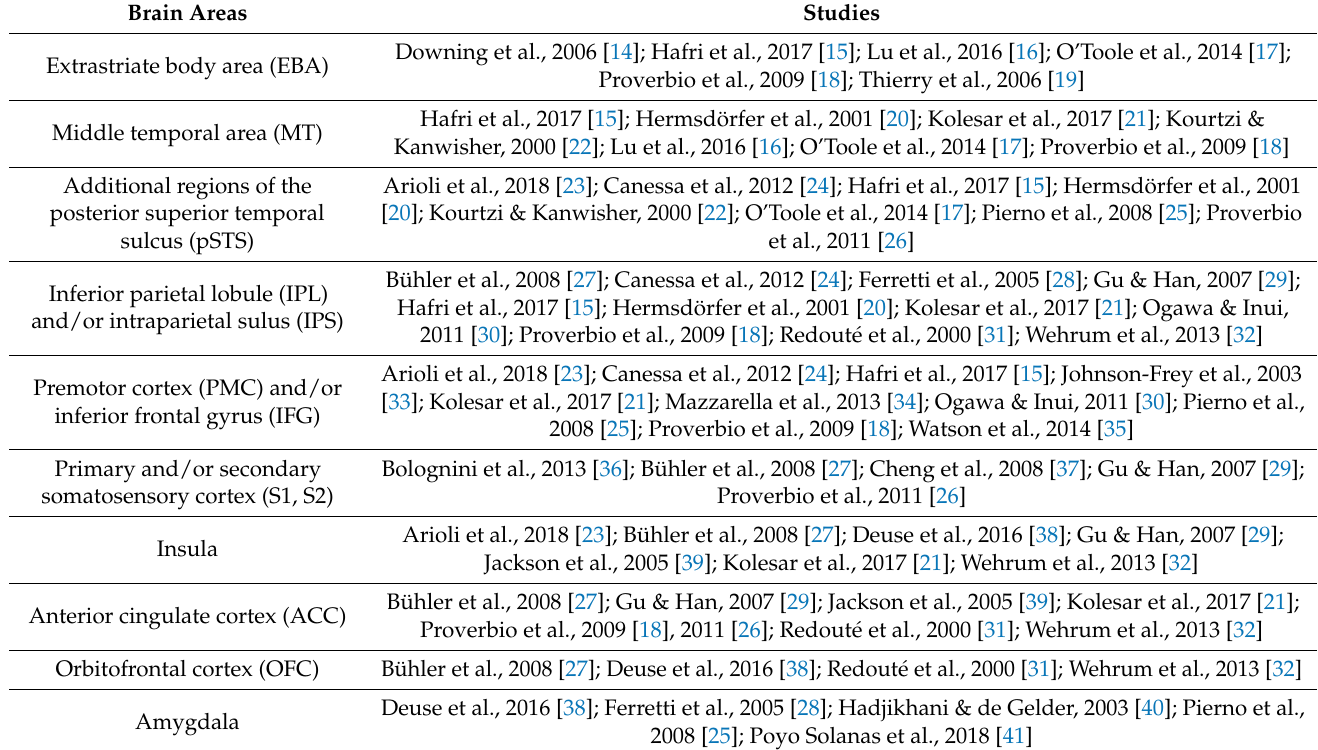
Table 1. Cortical areas and neuroscientific studies in which responses to photos of body movements or actions were observed and which were included in the present